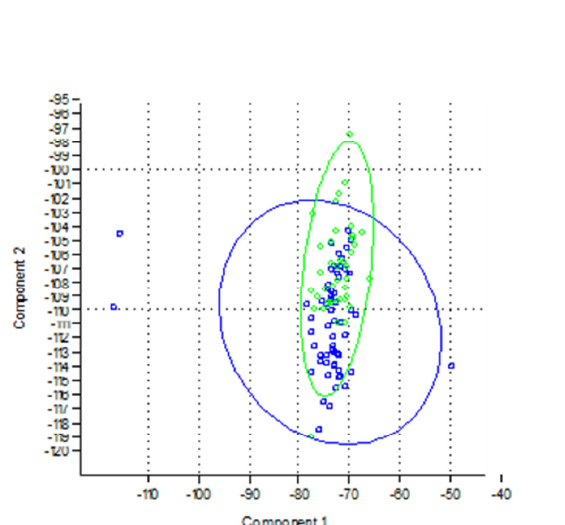
Fig. 1. PCA scatter diagram (95% ellipses) of morphometrics of wild and cultured samples of Clarias gariepinus showing overlap of traits *Blue color indicates wild samples, while green color indicates cultured